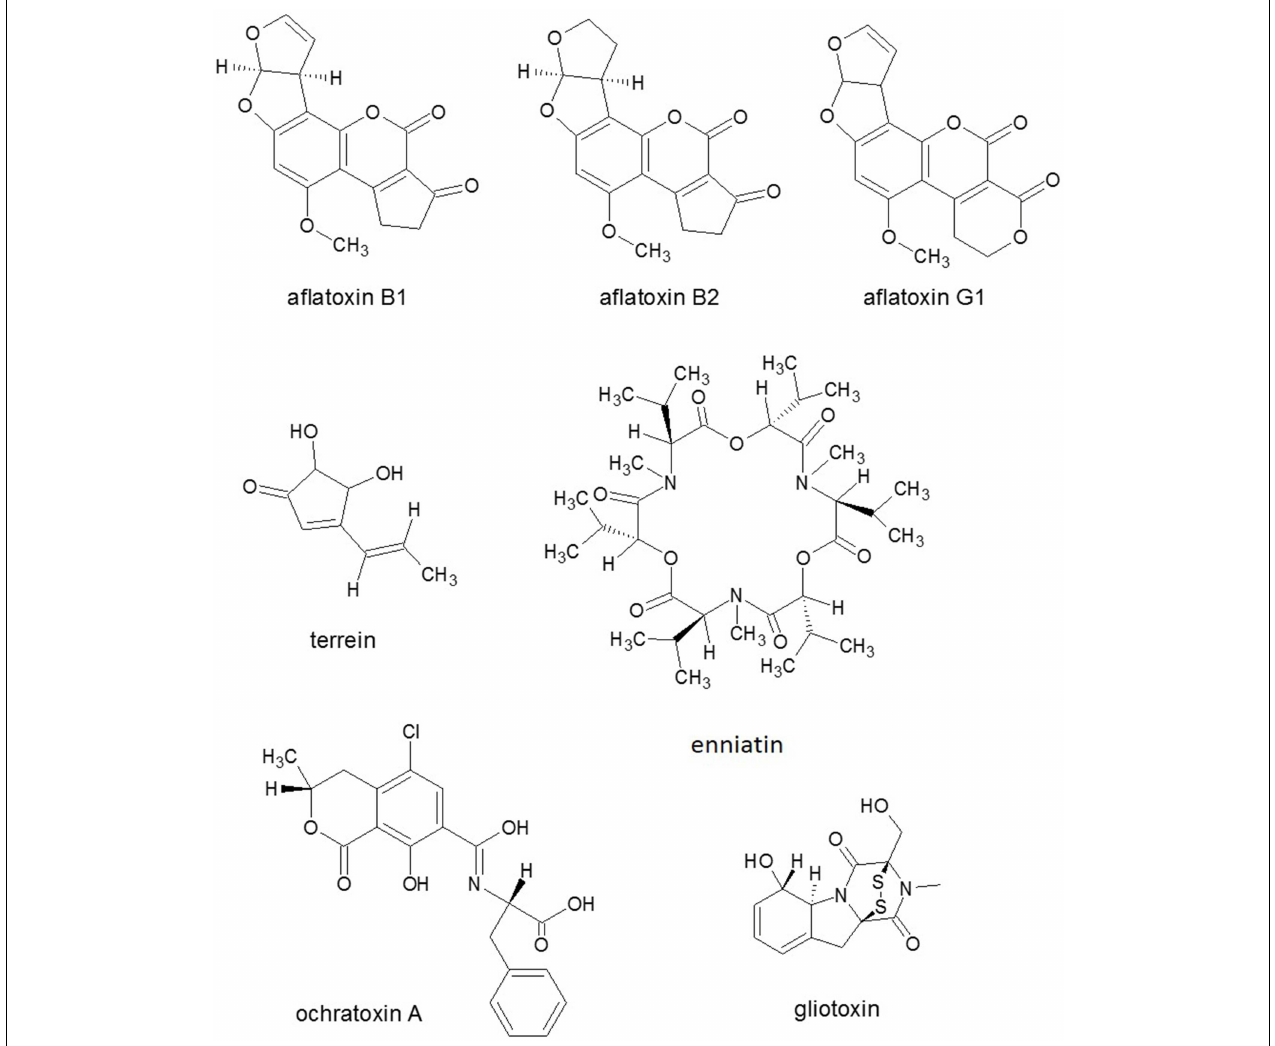
FIGURE 4 | Structures of representatives of Aspergillus SMs. Source: National Center for Biotechnology Information. PubChem Compound Database (accessed Jun. 6, 2015) (Bolton et al.,